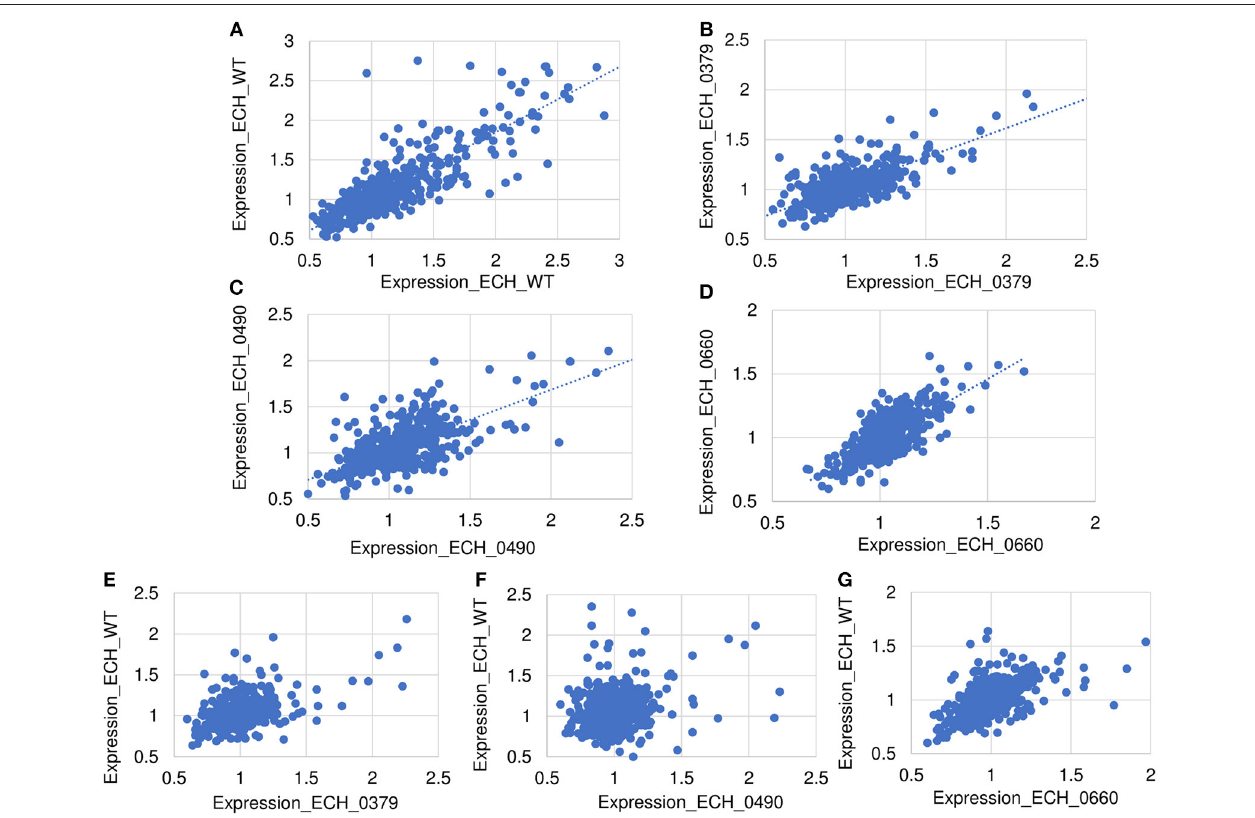
FIGURE 4 | Scatter plot of protein expression data. Scatter plots of protein expression data for replicates was presented for E. chaffeensis wild-type (A) and mutants ECH_0379 (B) , ECH_0490 (C) , and ECH_0660 (D) , which revealed a higher degree of correlation. Scatter plots of protein expression data for E. chaffeensis wildtype vs. mutant ECH_0379 (E) , wildtype vs. mutant ECH_0490 (F) , which revealed a lower degree of correlation, whereas the wildtype vs. ECH_0660 (G) had a higher level of correlation.